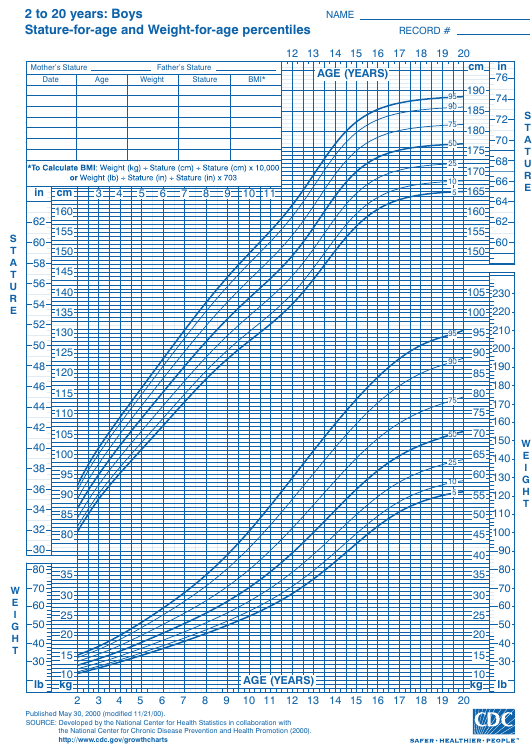
Figure 2. Clinical growth of boys measured by CDC (Age: 2–20 years) [2].